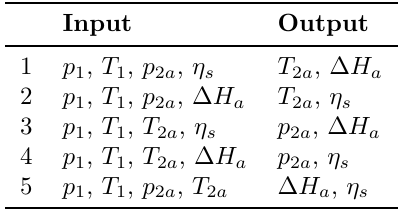
Table 2. Combination of output and input